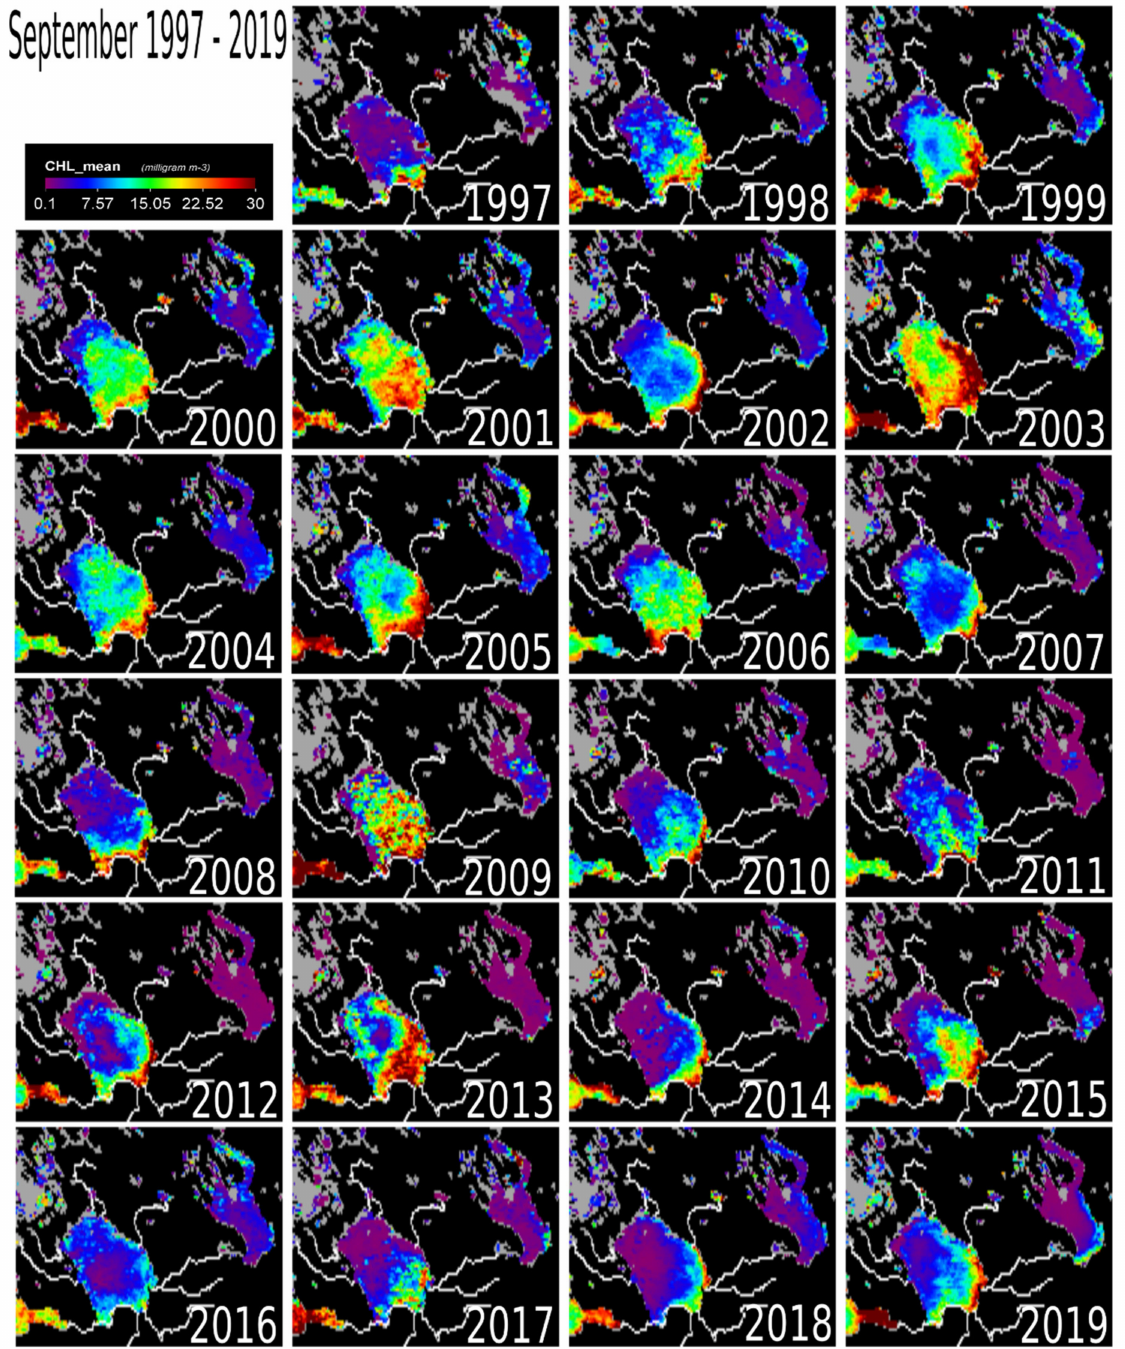
Figure 6. The map of chlorophyll-a concentration at Lake Ladoga for the month of September (1997–2019). Partially displayed as reference points are the Gulf of Finland (Southwest) and Lake Onega